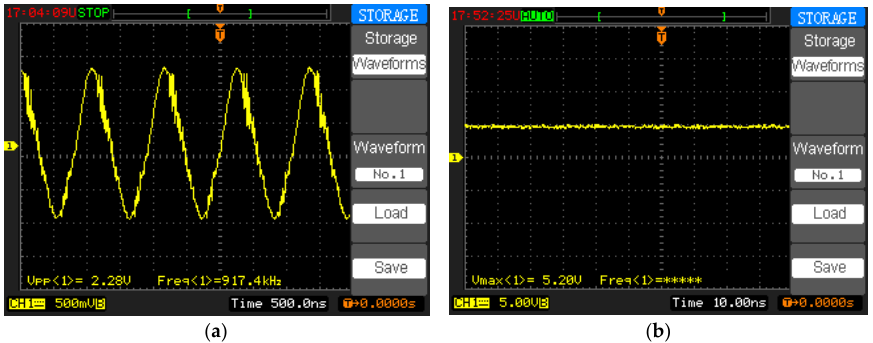
Figure 17. Oscilloscope measurement of ( a ) AC voltage and ( b ) DC voltage.